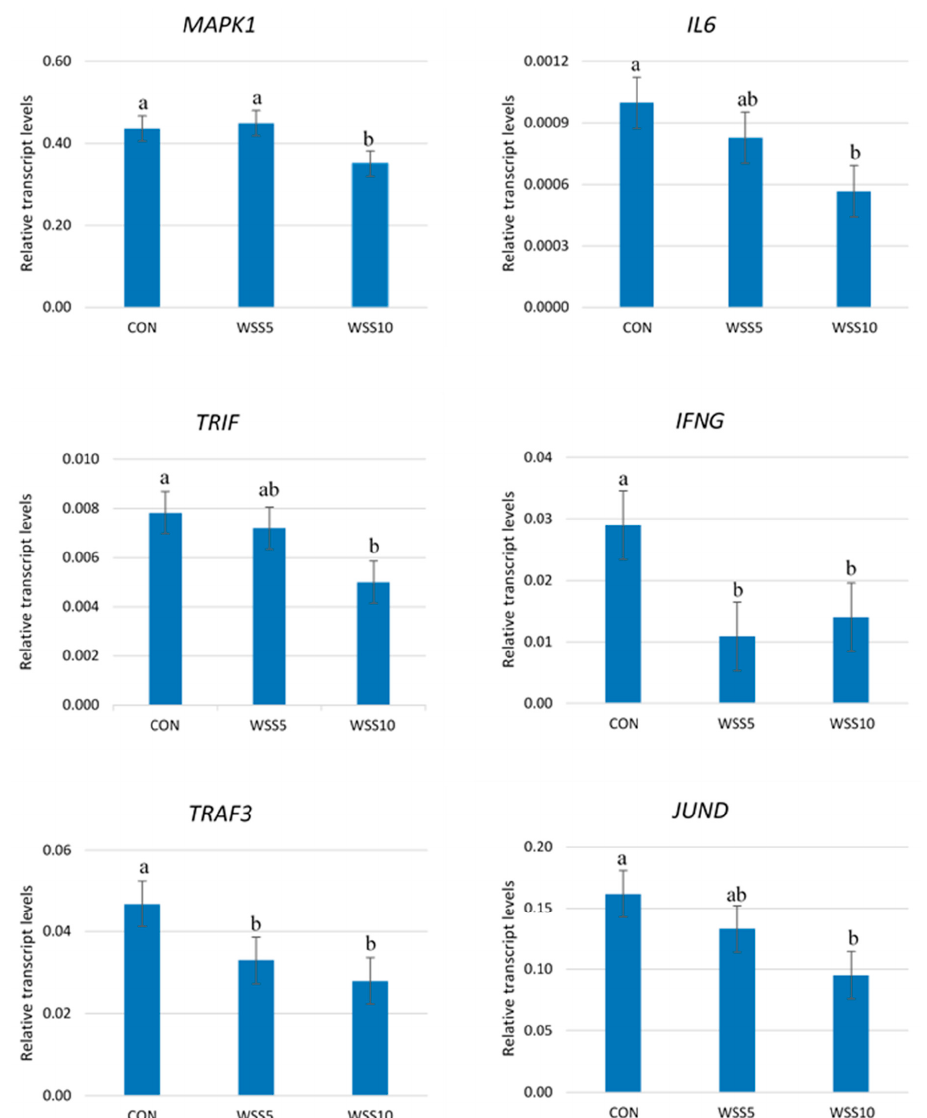
Figure 1. The Transcript abundance of several genes in the neutrophils of goats. Bars represent means ± SEM of each ( n = 8) of the three dietary treatments; CON: control, basal diet; WSS5: basal diet + 5% whole sesame seed; WSS10: basal diet + 10% whole sesame seed in goats. For each gene, bars with different superscripts (a, b) between the three dietary treatments (CON, WSS5, WSS10) differ significantly ( p ≤ 0.05), according to the analysis of variance (ANOVA) using a general linear model (GLM) for repeated measures. Post hoc analysis was performed using Duncan’s multiple range test. The same trend was found for the IFNG and TRAF3 genes in the neutrophils of SS5 fed goats (Figure 1). No differences were found in the expression levels of the above genes between the treated groups (Supplementary Figure S1).